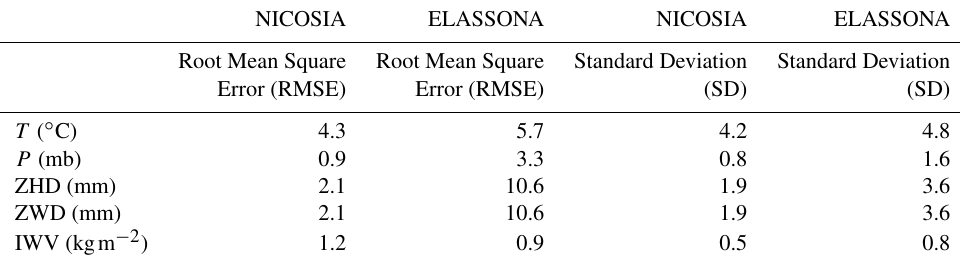
Table 1. The RMSE of absolute bias and Standard Deviations (a) between in situ meteorological observations and GPT2w modelled values of T , P and (b) between parameters (ZHD, ZWD, IWV) retrieved from GNSS observations by using GPT2w model atmospheric variables ( T , P ) and the respective ones retrieved from GNSS observations by using T , P obtained from in situ meteorological stations, for both stations during the period of